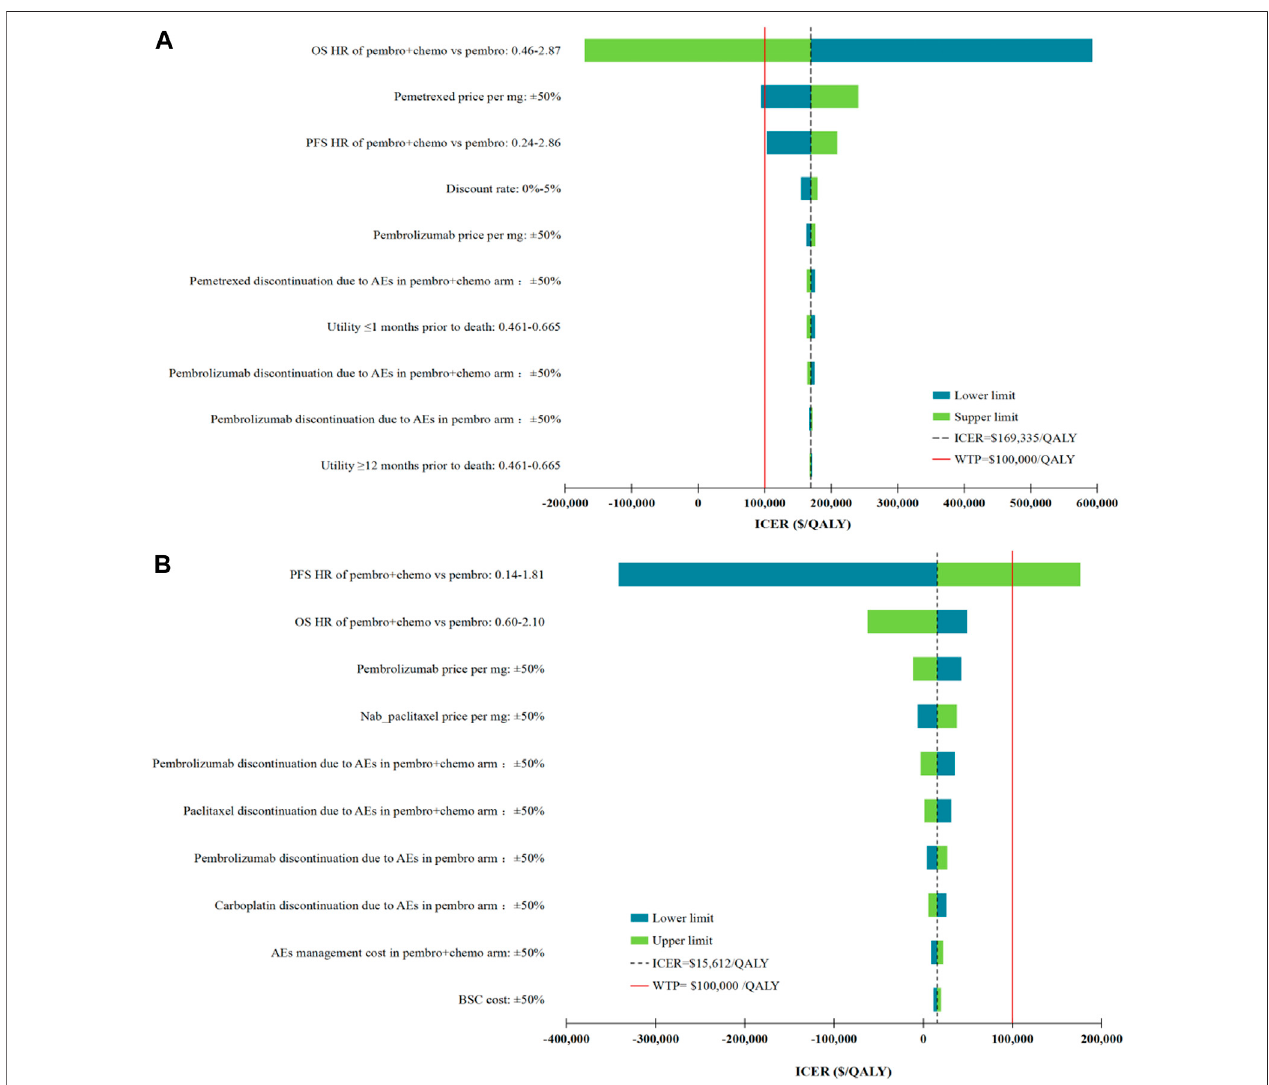
FIGURE 2 | Deterministic sensitivity analysis results. (A) , the top 10 parameters with the greatest in fl uence on the ICER of fi rst-line Pembro+Chemo vs Pembro in non-squamous NSCLC patient population; (B) , the top 10 parameters with the greatest in fl uence on the ICER of fi rst-line Pembro+Chemo vs Pembro in squamous NSCLC patient population. ICER, incremental cost-effectiveness ratios; QALY, quality-adjusted life-years; AEs, adverse events; OS, overall survival; PFS, progression- free survival; HR, hazard ratios; BSC, best supportive care.